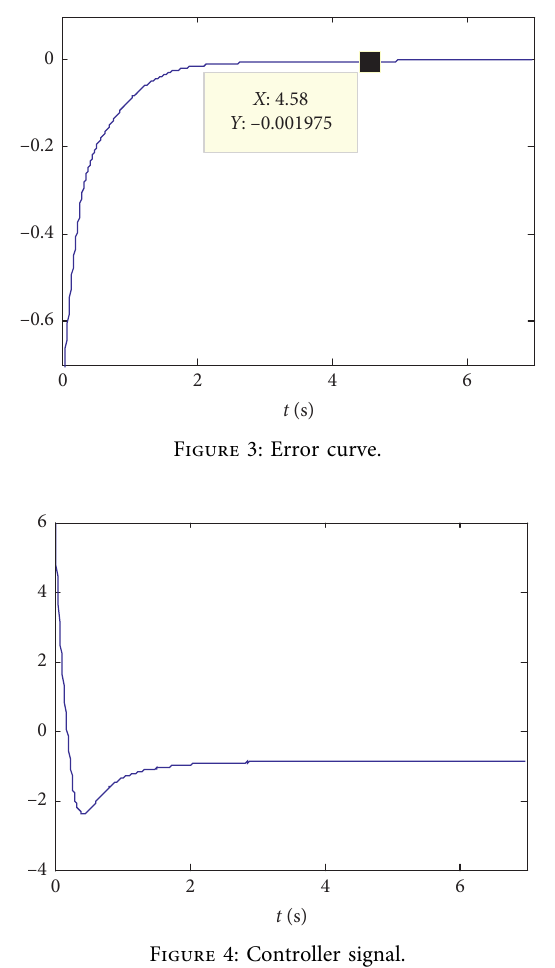
Figure 4: Controller signal.